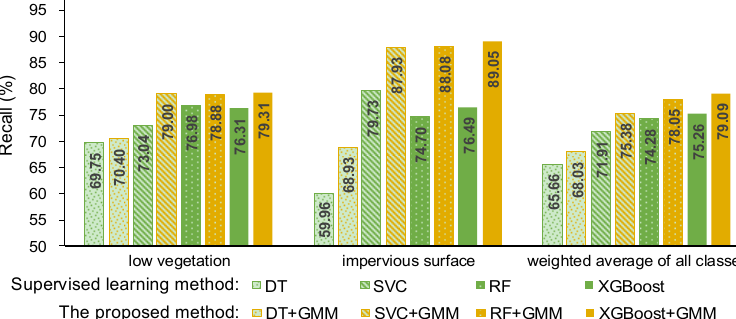
Figure 5. Recall of the supervised learning method without intensity and the proposed method.